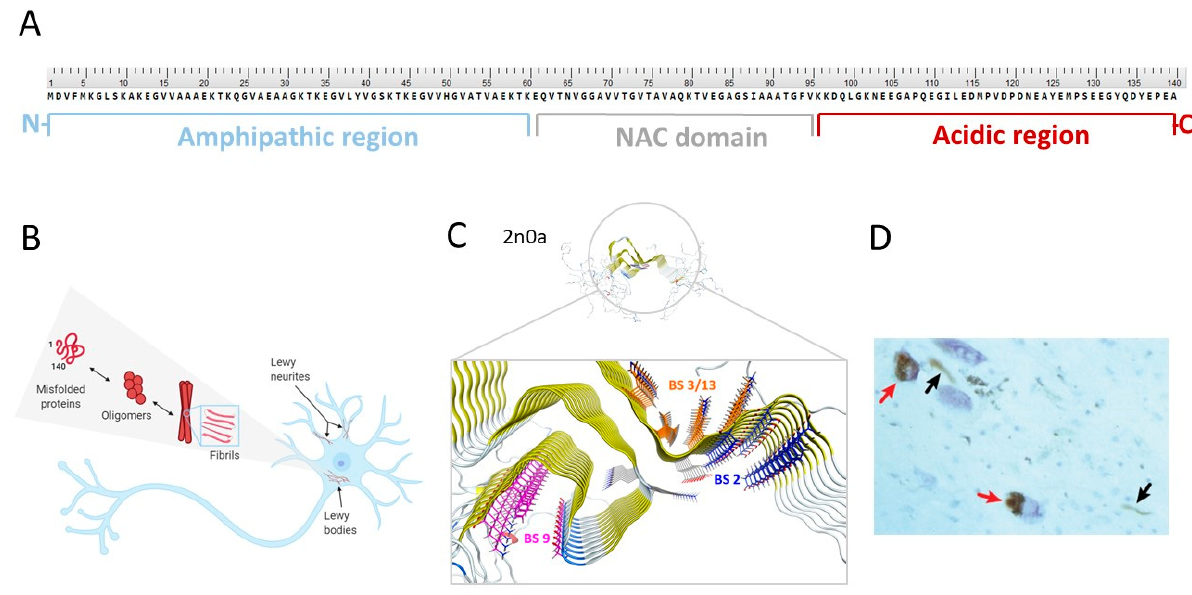
Figure 2. ( A ) Primary structure of α -syn with highlighted regions: N-terminal (in blue), NAC (in grey), and C-terminal (in red). ( B ) Conformational states of α -syn (adapted from [41] and visualized with BioRender). ( C ) Solid-state NMR atomic-resolution (4.8 Å) of α -syn fibrils (PDB ID: 2n0a, adapted from Twohig et al. [42]) with putative binding sites: binding site 2 (BS2; in blue), binding site 9 (BS9; in pink), binding site 3/13 (BS3/13; in orange) on α -syn fibrils (reprinted with permission from [43]. Copyright 2018 American Chemical Society. Structure of α -syn was imported from PDB and visualized with MOE 2018). ( D ) The α -syn pathology of PD with two pigmented nerve cells containing LB (red arrows) and LN (black arrows). (Adapted from [19]).